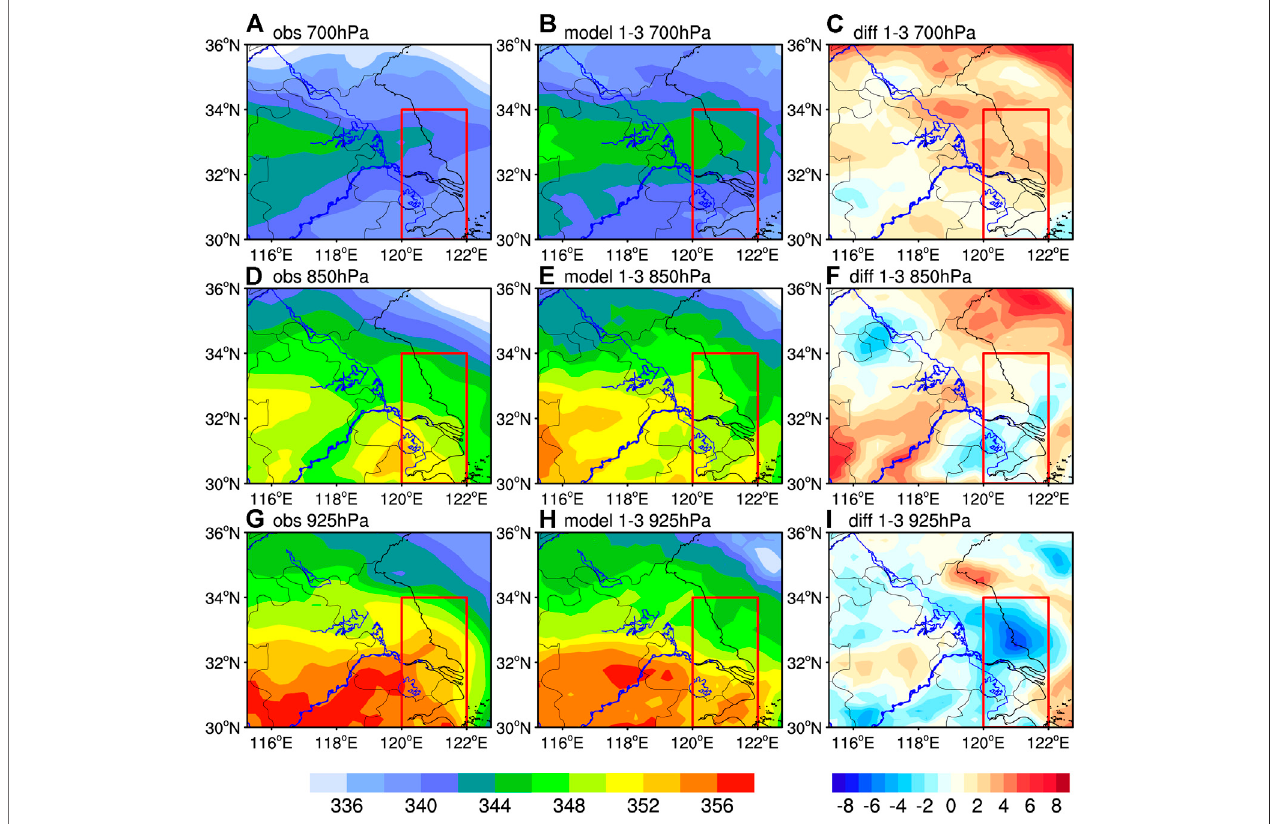
FIGURE 10 | Composites of pseudo-equivalent potential temperature ( θ se , · K ) during WRWS occurrence moments in observations (A,D,G) and the PWAFS forecasts (B,E,H) , as well as their differences (C,F,I) at 700 hPa (A,B,C) , 850 hPa (D,E,F) , and 925 hPa (G,H,I) .